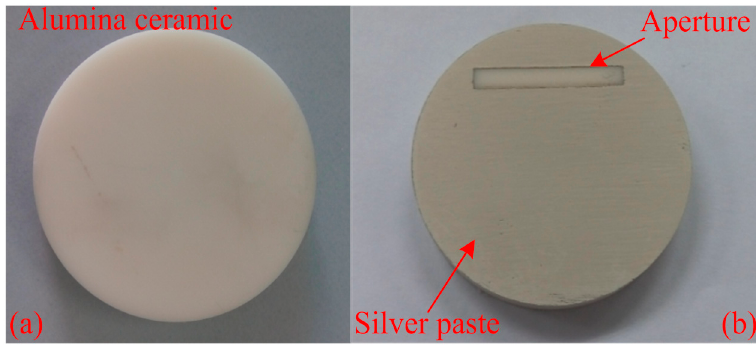
Figure 6. Sensor fabrication process. ( a ) Alumina ceramic; ( b ) Fabricated temperature sensor.